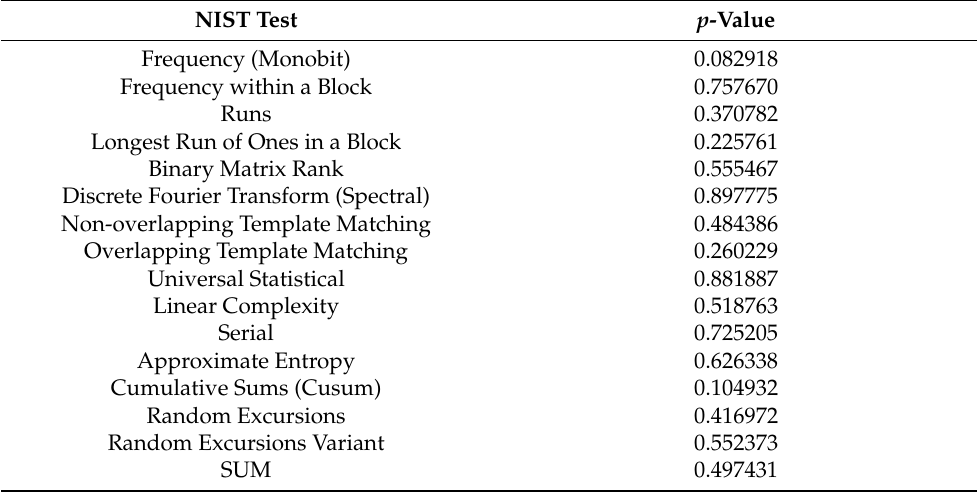
Table 1. The result of the National Institute of Standards and Technology (NIST)